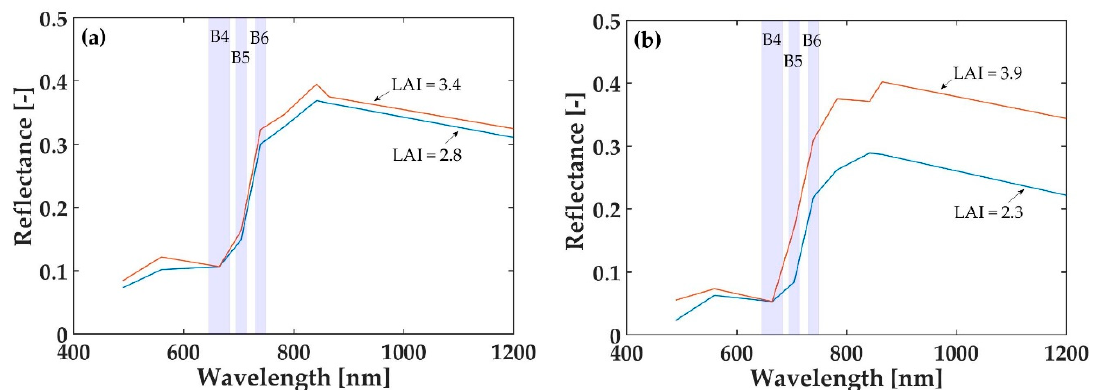
Figure 6. Representation of real Sentinel-2 top-of-canopy (TOC) reflectance spectra of (a) artichoke crops (20/07/2017 Sentinel-2 image used) and ( b ) orange tree crops (07/11/2017 Sentinel-2 image used). The red and red-edge Sentinel-2 bands (B4, B5 and B6) are represented with their corresponding bandwidth.